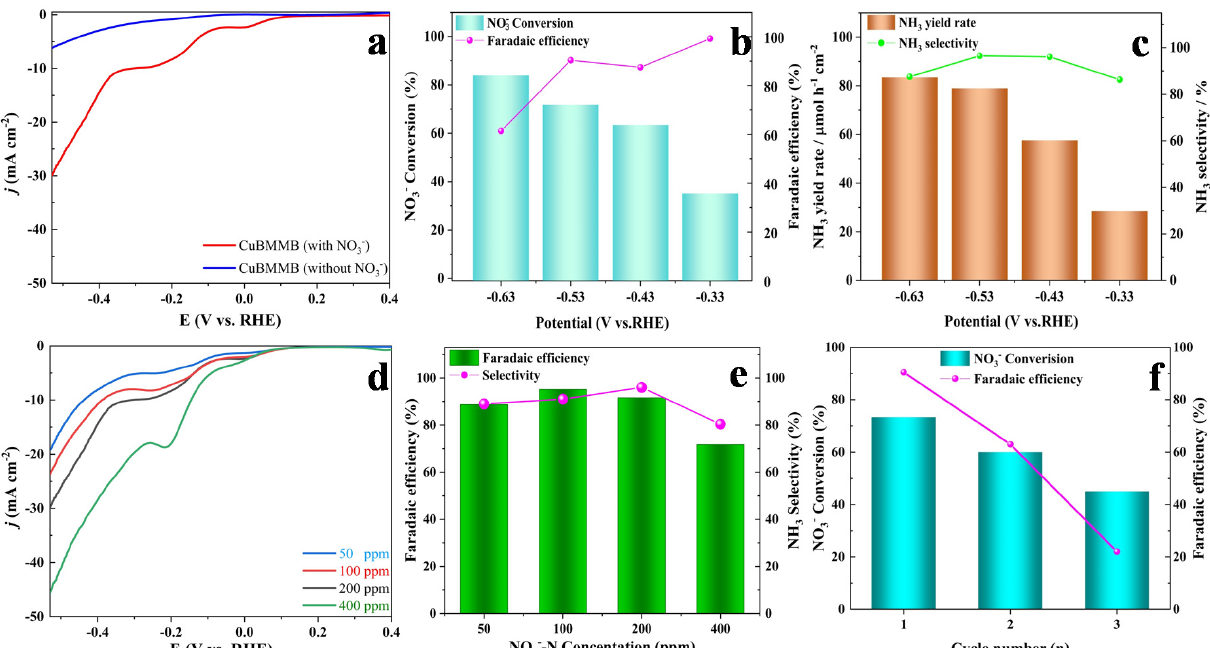
Figure 4. NRA electrocatalytic performance. ( a ) LSV curves of CuBMMB in 1 M KOH electrolyte with and without NO 3– , respectively; ( b ) potential − dependent FE and selectivity of NH 3 over CuBMMB in 1 M KOH electrolyte with 200 ppm NO 3– ; ( c ) NH 3 yield rate and NH 3 selectivity of CuBMMB electrodes under different potentials; ( d ) LSV curves of CuBMMB tested with different NO 3– -N concentrations; ( e ) FE and selectivity of NH 3 tested at − 0.53 V vs. RHE over CuBMMB in 1 M KOH electrolyte with 50, 100, 200, and 400 ppm NO 3– -N concentrations; ( f ) the consecutive recycling test of CuBMMB at − 0.53 V vs. RHE 1 M KOH electrolyte with 200 ppm NO 3– .